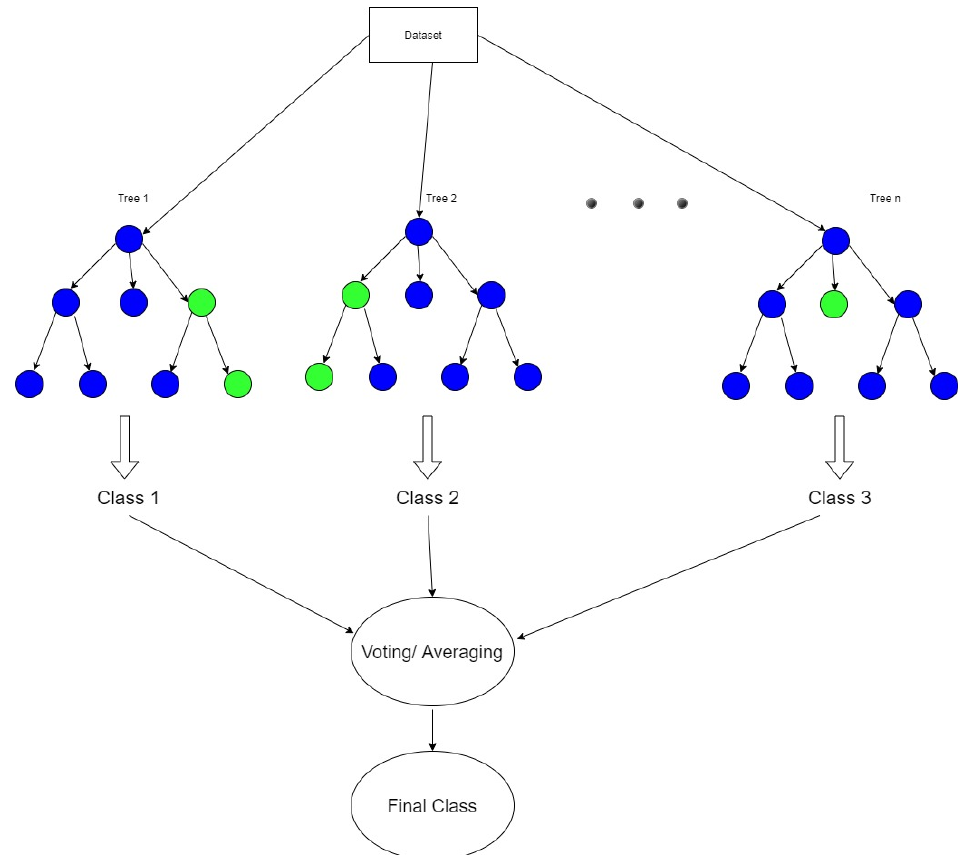
Figure 1. Random Forest